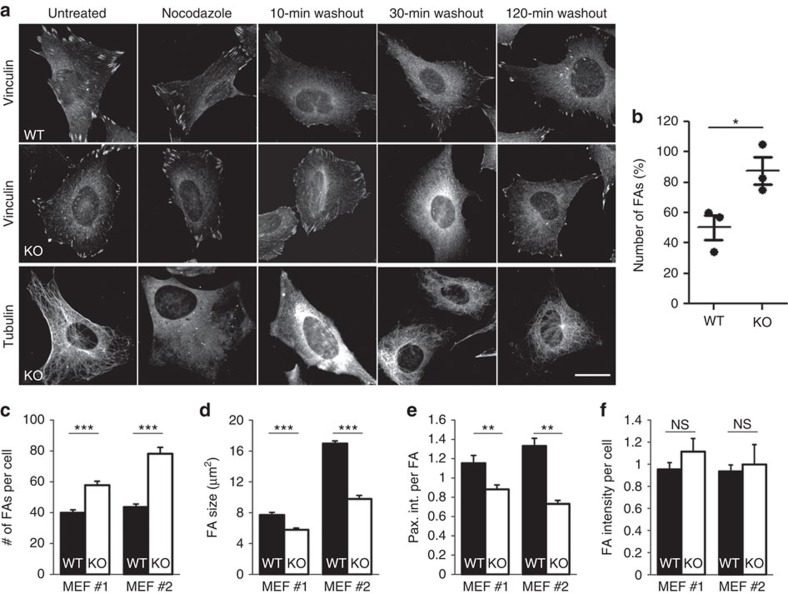
Stonin1 is required for FA disassembly.(a,b) Loss of Stonin1 slows FA disassembly. (a) Starved WT and Stonin1−/− MEFs were left untreated or were incubated with 10 μM nocodazole. After 4 h, nocodazole was washed out to allow microtubule regrowth to trigger FA disassembly. Cells were fixed and immunostained with vinculin- and tubulin-specific antibodies. Scale bar, 25 μm. (b) The number of FAs in WT and Stonin1−/− cells after 10 min of nocodazole washout relative to untreated cells was quantified by thresholded particle counting of vinculin-positive FAs (data are depicted as mean±s.e.m., N=3, n>100, unpaired two-tailed Student's t-test, *P<0.05). (c–f) Alterations in steady-state FA number and size upon Stonin1 deletion. Quantification of FA number per cell (c), FA size (d) Paxillin intensity per FA (e) and total Paxillin intensity per cell (f) in two independent WT and Stonin1−/− MEFs lines fixed and stained with Paxillin-specific antibodies (data are depicted as mean±s.e.m., N=3, n=116, unpaired two-tailed Student's t-test, ***P<0.001, **P<0.01). NS, not significant.